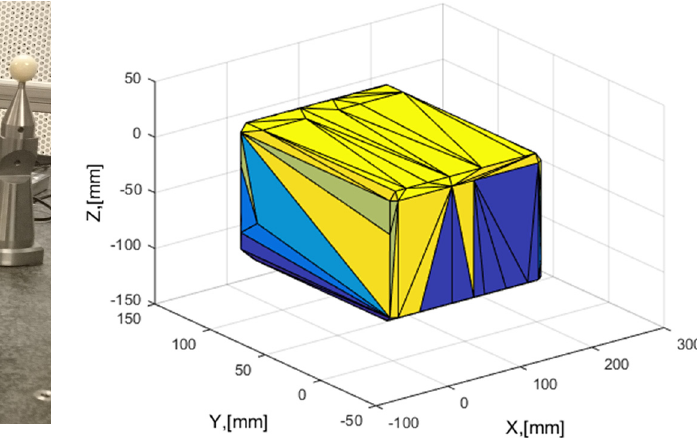
Fig. 12. The result of the 3D convex hull operation.